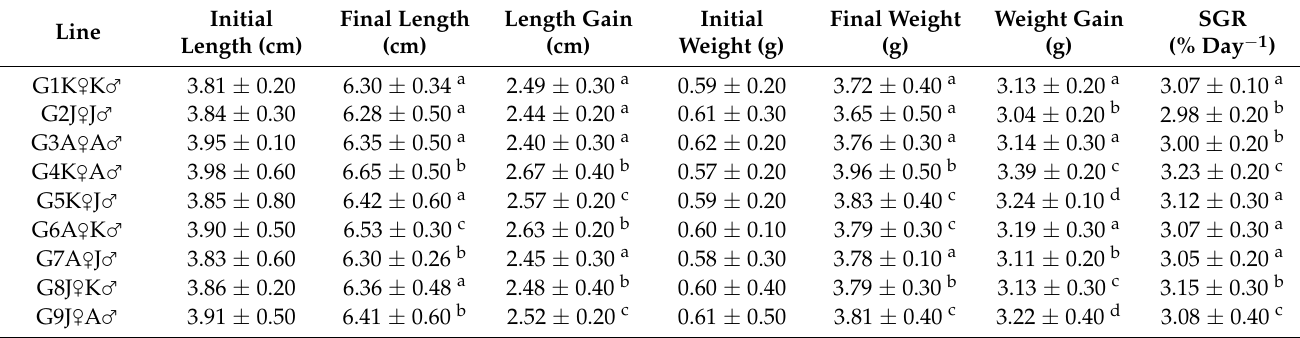
Table 4. Growth performance of the fry of three parental and six reciprocal crosses of Ariza labeo ( L. ariza ) after 90 days of rearing in earthen pond condition † . The single words picked to name the purebred and crossbred groups bear the full forms as G → Group, K → Kangsha River stock, J → Jamuna River stock and A → Atrai River